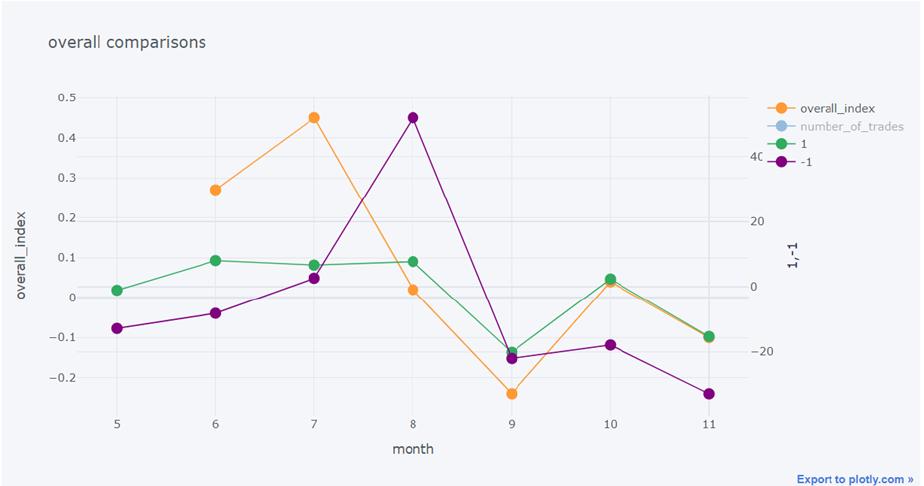
Figure 6. signal trends in cluster